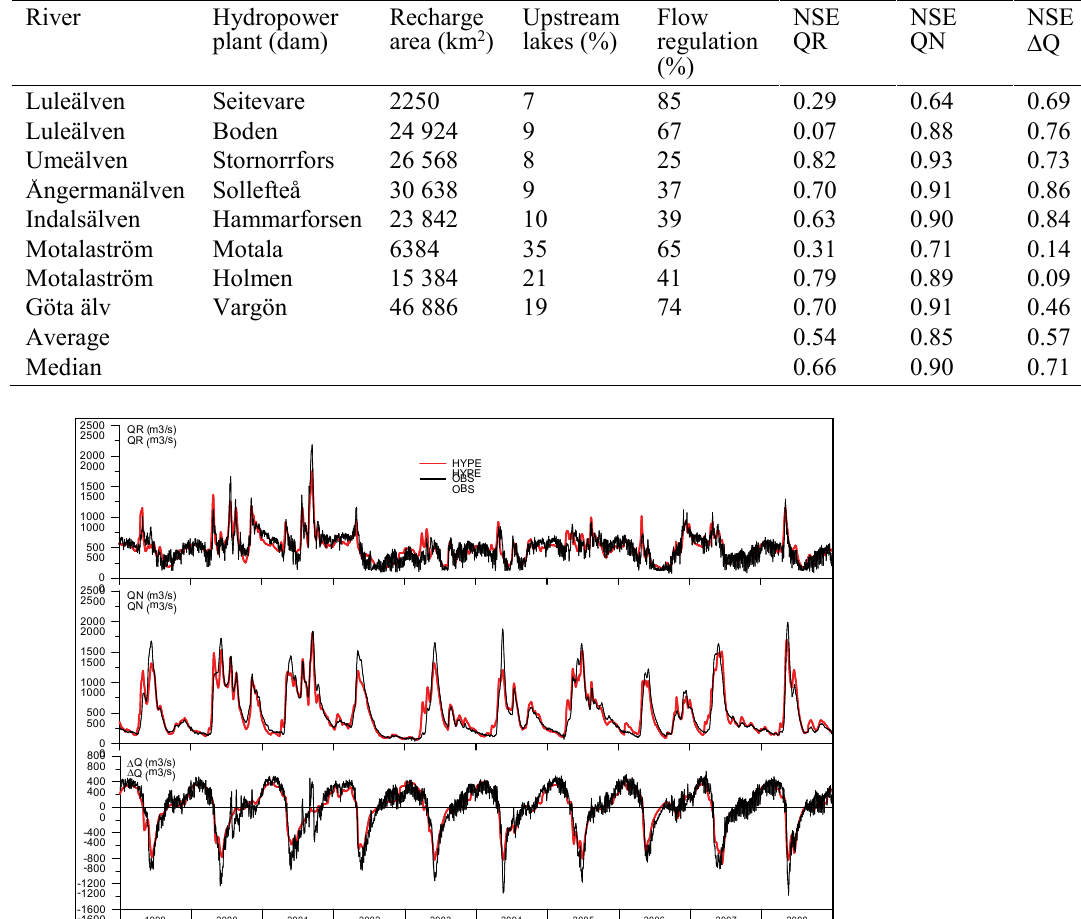
Table 1 S-HYPE model performance (NSE) at the eight hydropower plants using daily values for river flow including regulation (QR) tested against observations; for naturalized conditions (QN) tested against independent reconstruction; and for the hydropower impact ( ΔQ ) tested against observations combined with independent reconstructions.